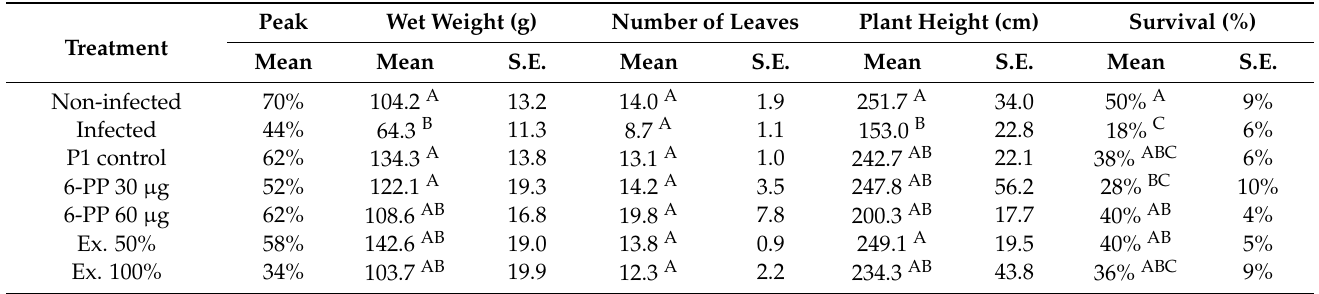
Table 6. 6-pentyl- α -pyrone late wilt control in the net house at the sprouting phase 1